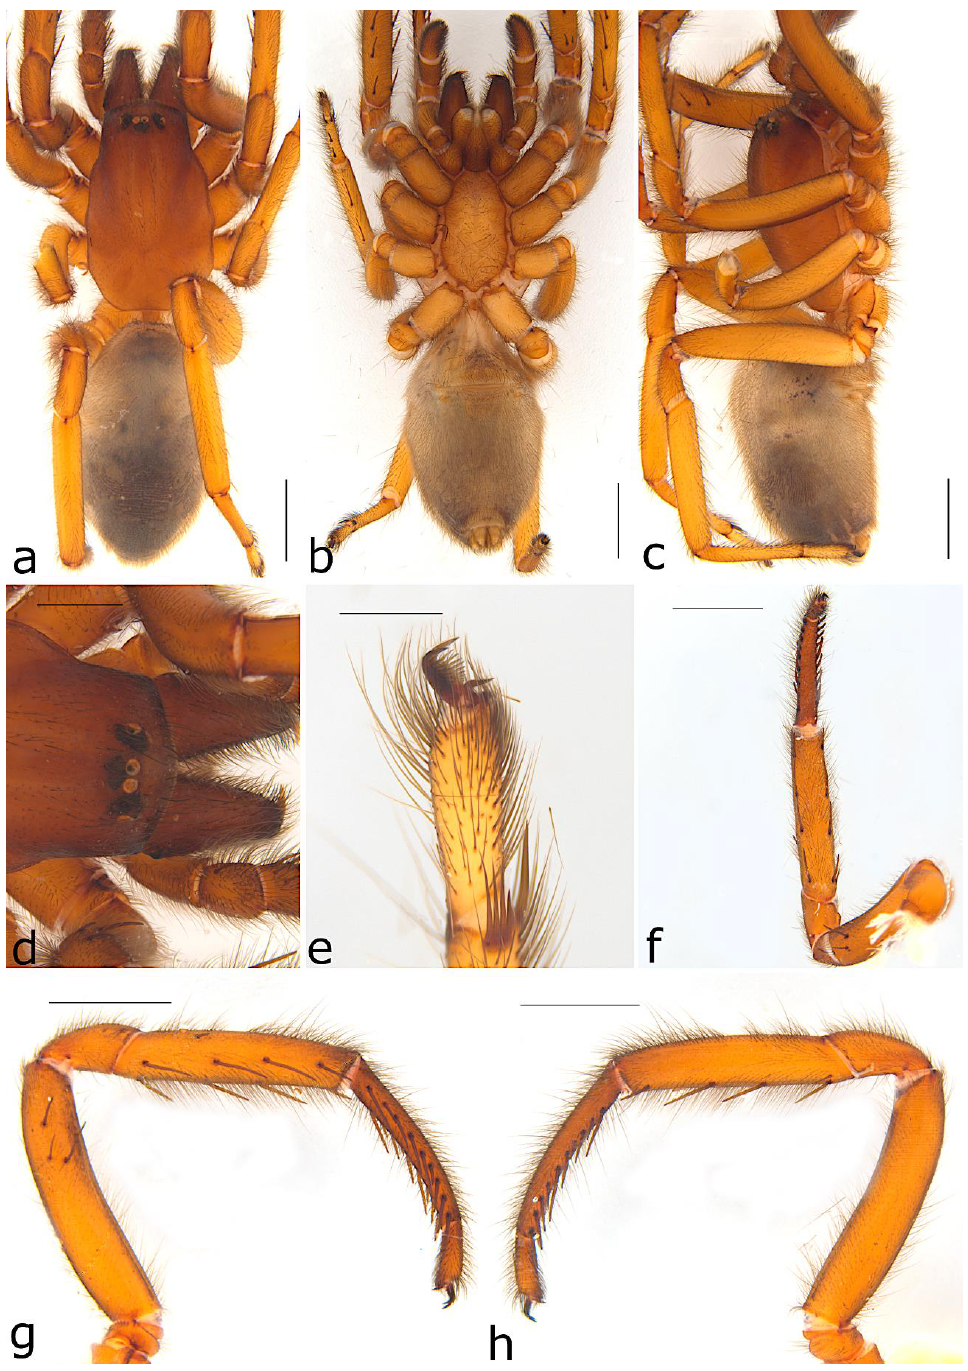
Figure 71. Ariadna valida sp. nov. ♀ paratype (SAMA NN30489) from Mamungari (SA): ( a ) habitus, dorsal view; ( b ) same, ventral view; ( c ) same, lateral view; ( d ) eyes, dorsal view; ( e ) left metatarsus IV, preening comb, retrolateral view; ( f ) left leg I, ventral view; ( g ) same, prolateral view; ( h ) same, retrolateral view. Scale bars ( a – d , f – h ) = 1 mm and ( e ) = 0.5 mm. Cephalothorax: 5.1 long, 3.1 wide, 3.1 high. Carapace golden orange-brown. Sternum pale cream-brown, with fine, faint dark medial strip anteriorly, which continues on to labium. Maxillae and labium orange-brown, paler apically; chelicerae darker red-brown. Figure 71a–c. Carapace elongated oblong, with undulating lateral edges and forming a broad, squared neck anteriorly. Fovea an indistinct shallow indented pit (Figure 71a). Labium around three quarters the length of the maxillae. Sternum elongate oval,